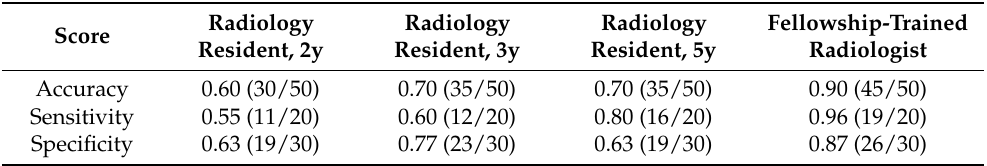
Figure 4. Axial T2-weighted ( A ) and T1-weighted ( B ) MR images showing a well-defined intramuscular lipomatous tumor (lipoma) in the right posterior thigh without significant contrast enhancement on the axial T1-weighted image with fat saturation ( C ). ( D ) The machine-learning model classified this tumor as a lipoma (probability of 97.8%). This was in accordance with the diagnosis made by the radiology residents and the attending radiologist. Table 3. Performance of the radiology residents with 2, 3, or 5 years of experience and the fellowship- trained radiologist that was experienced in musculoskeletal tumor imaging. Readers were blinded to all clinical and histopathological